Question: What does this figure show? Answer in one sentence.
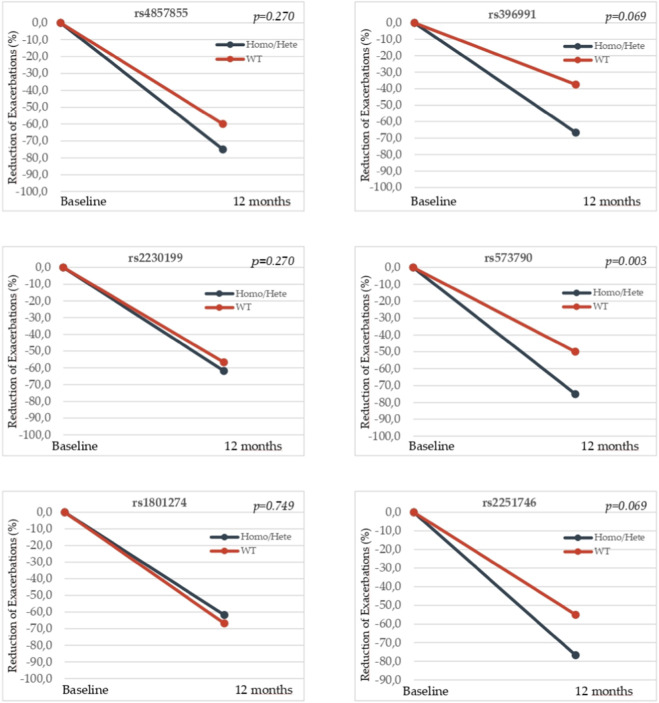
Answer: Percentage reduction in asthma exacerbations after 12 months of omalizumab treatment by genotype. Median percentage reduction in exacerbations observed in wild-type (WT) versus variant allele carriers for each SNP. Statistical comparisons performed using the Mann–Whitney U test.